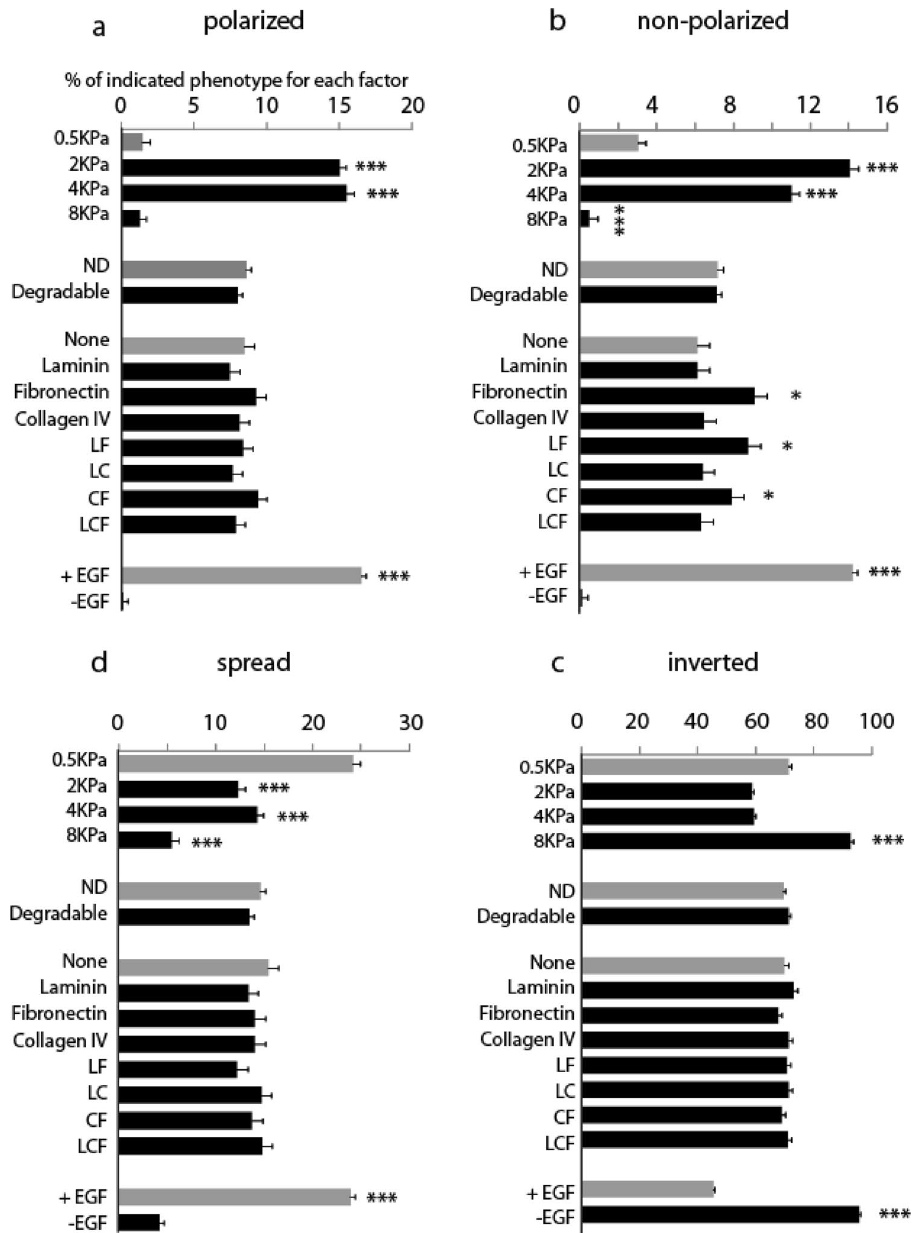
Figure 4. Global factor analysis for mammary epithelial colony phenotype. A GLM model is developed for each phenotype, which provides a characteristic microenvironmental signature for ( a ) polarized, ( b ) non- polarized, ( c ) spread and ( d ) inverted colonies. LF: laminin + fibronectin, LC: laminin + collagen IV, CF collagen IV + fibronectin, LCF laminin + collagen IV + fibronectin. The numbers on the x-axis indicate the average proportion of each phenotype within each well, for the given factor within the category. Statistical analysis identifies the significance of the change with respect to the condition in light gray for every category. Error bars represent s.e.m. All pairwise differences were computed using the Tukey–Kramer method. *** P < 0.001, ** P < 0.01, * P <